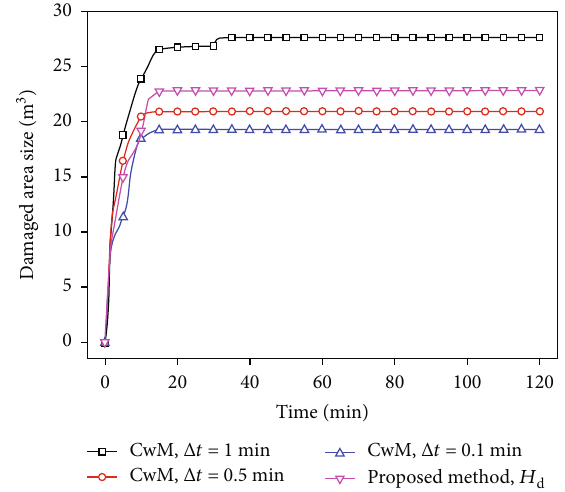
Figure 8: Damaged area size of the CwM method and proposed method.